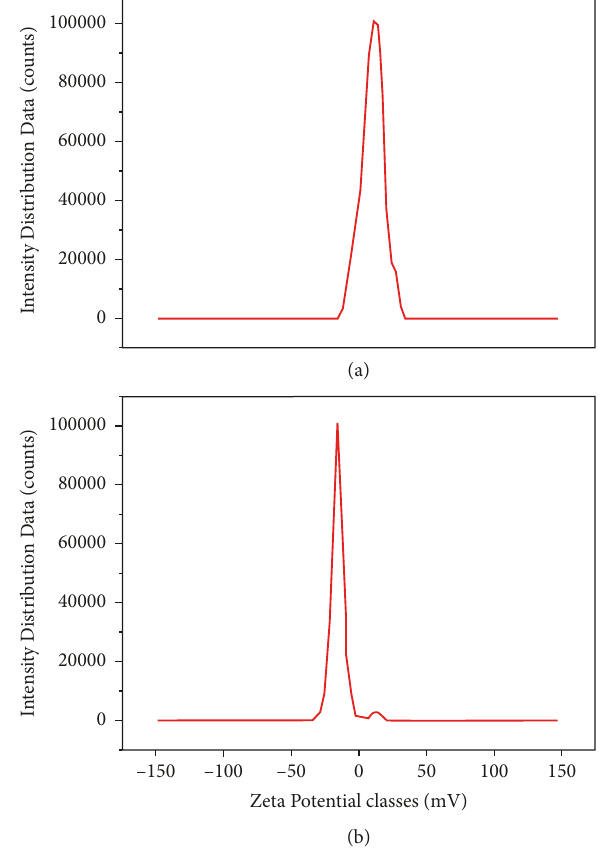
Figure 7: Zeta potential of (a) zinc oxide nanoparticles (ZnONPs) and (b) plant-fabricated zinc oxide nanoparticles (PF-ZnONPs).